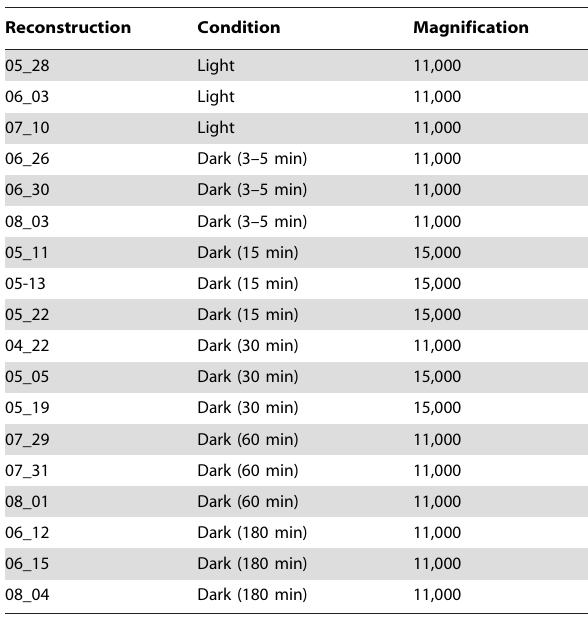
Table 1. List of reconstructions.